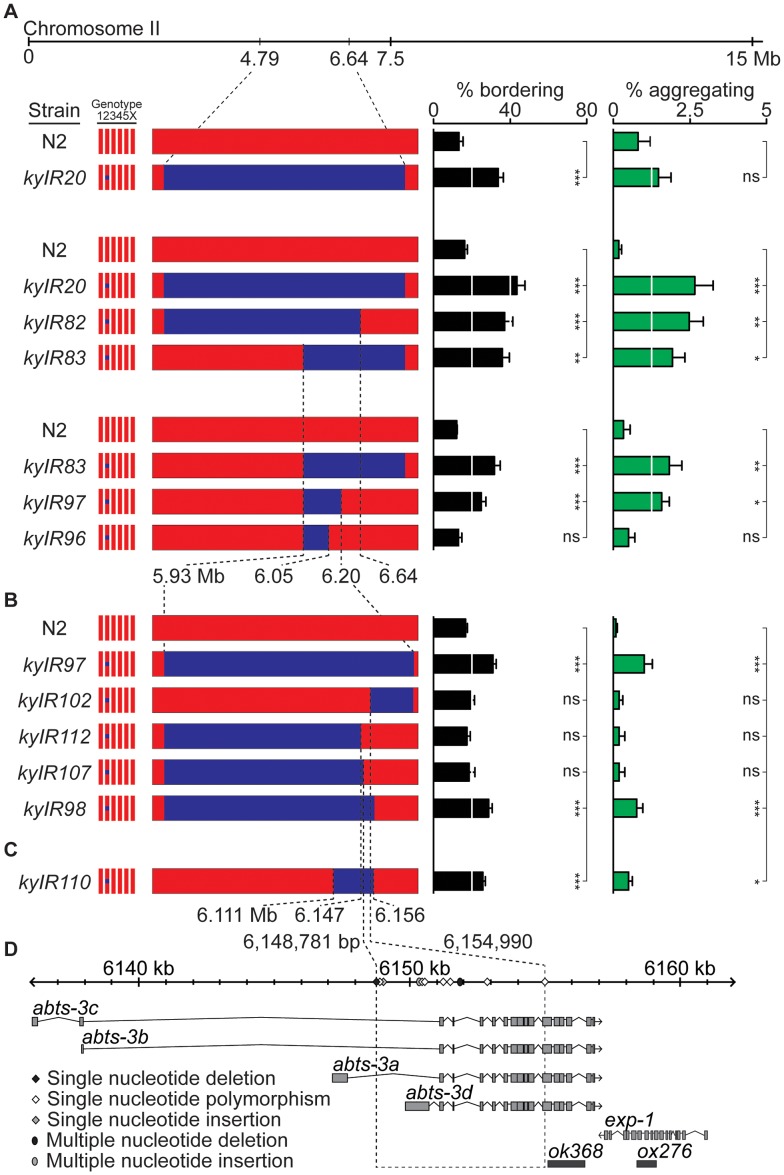
A social behavior II-QTL maps to a 6.2 kb region.(A) Bordering and aggregation behaviors of recombinants in the II-QTL region introduced as NILs into an N2 background. (B) Behaviors of NILs derived from kyIR97. (C) Behaviors of kyIR110, a near-isogenic line containing 45 kb of HW DNA in an N2 background. (D) Expansion of the 6.2 kb QTL, showing polymorphisms between N2 and HW, location of transcripts (see Methods), and location of deletion alleles used in Figure 3 and Figure 4. Error bars, s.e.m. * P<0.05, ** P<0.01, *** P<0.001 by t-test or ANOVA with Dunnett test. ns, not significant.